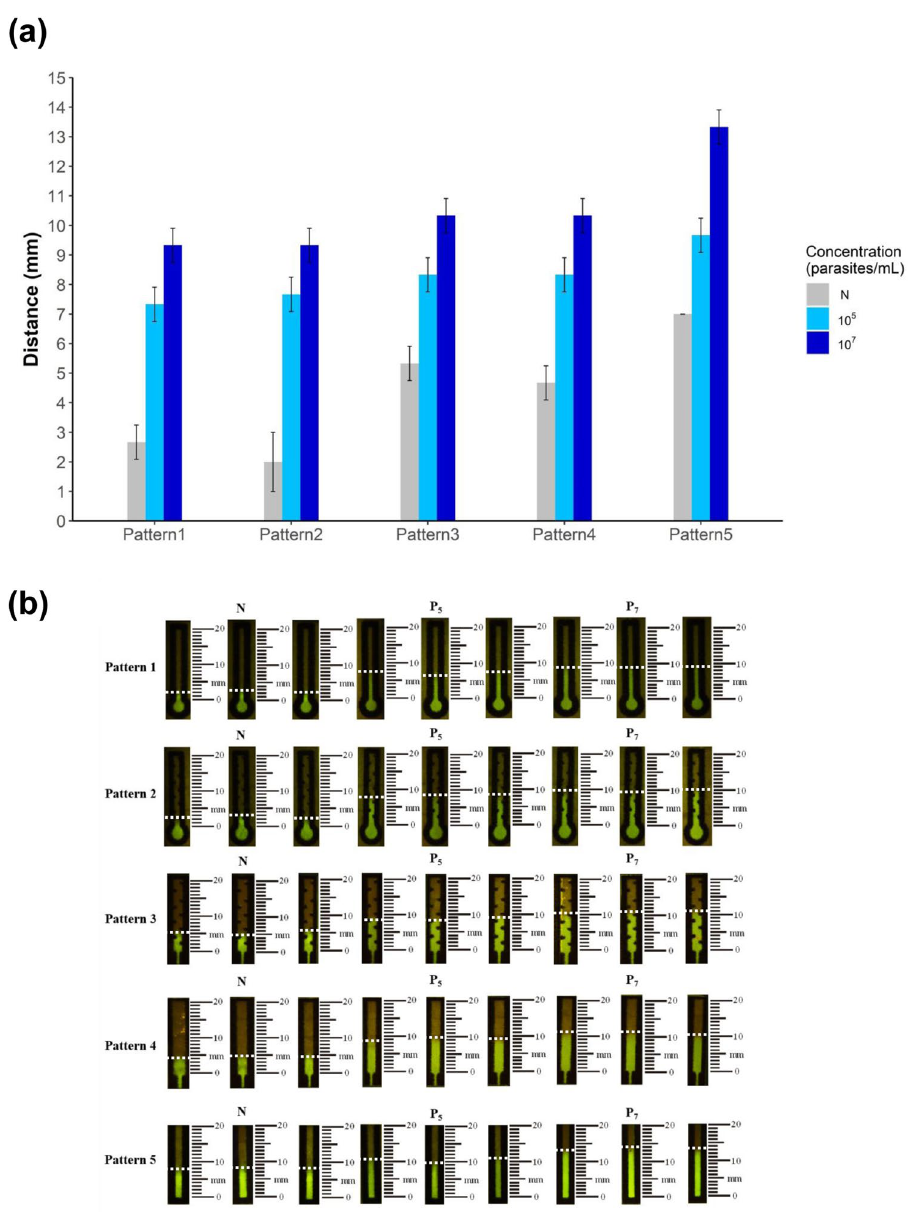
Figure 3. Effect of different patterns of sample and detection channel zones to immobilize migratory distance of LAMP reaction mixture on a distance-based paper device (dPAD), ( a ) mean and standard deviation of fluorescent migratory distance of five different patterns of dPAD, ( b ) fluorescent visualization of migratory distance of five patterns on dPAD. Abbreviations of variable names: no template control (N), positive Leishmania template control at 10 5 and 10 7 parasites/mL (P 5 , P 7 ,